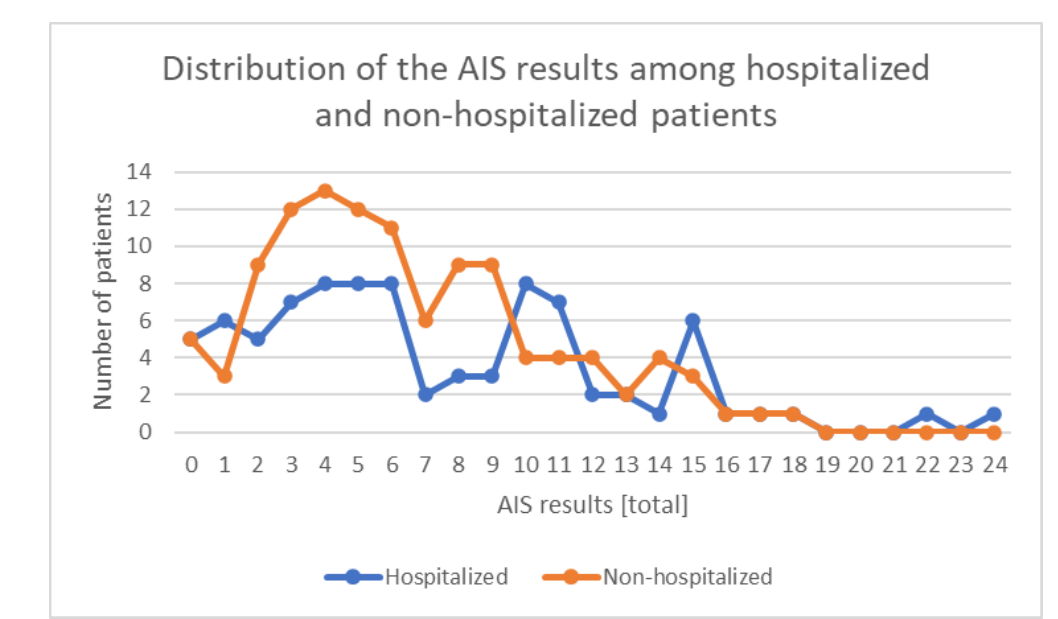
Figure 8. Distribution of the AIS results among hospitalized and non-hospitalized patients. The descriptive statistics divided between hospitalized and non-hospitalized patients for all of the AIS questions are presented below (Table 3). Table 3. Basic characteristics of the results obtained in the AIS divided between hospitalized and non- hospitalized patients. Hospitalized